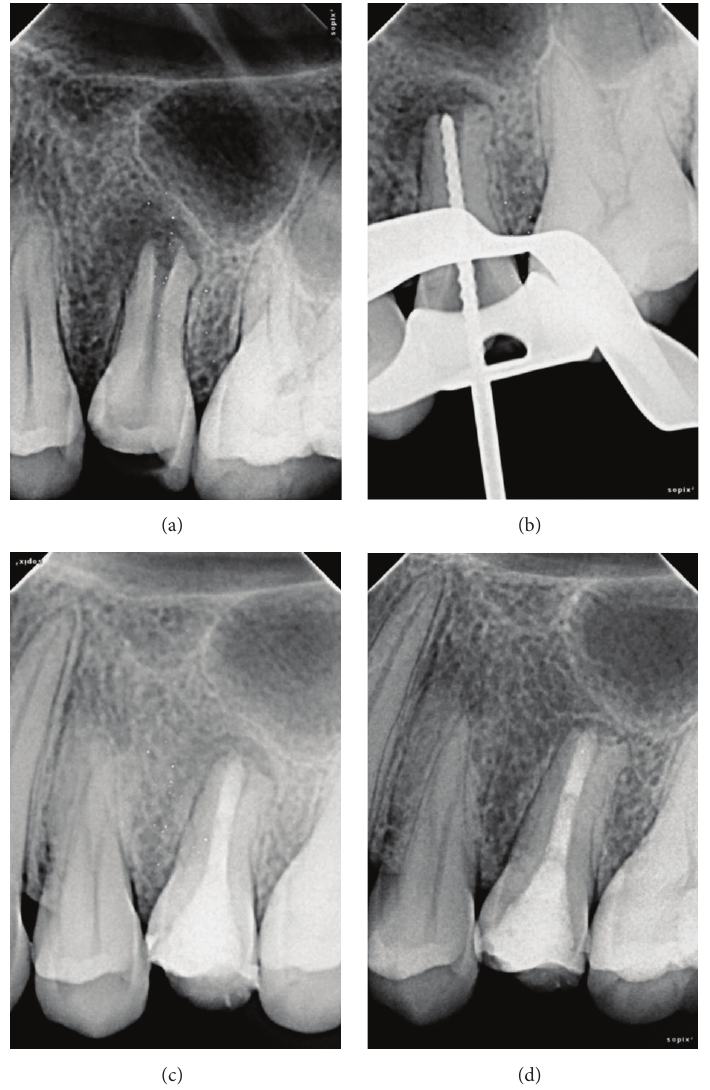
Figure 2: (a) Preoperative radiograph (Case 2). (b) Working length radiograph (Case 2). (c) MTA obturation (Case 2). (d) One-year follow- up radiograph (Case